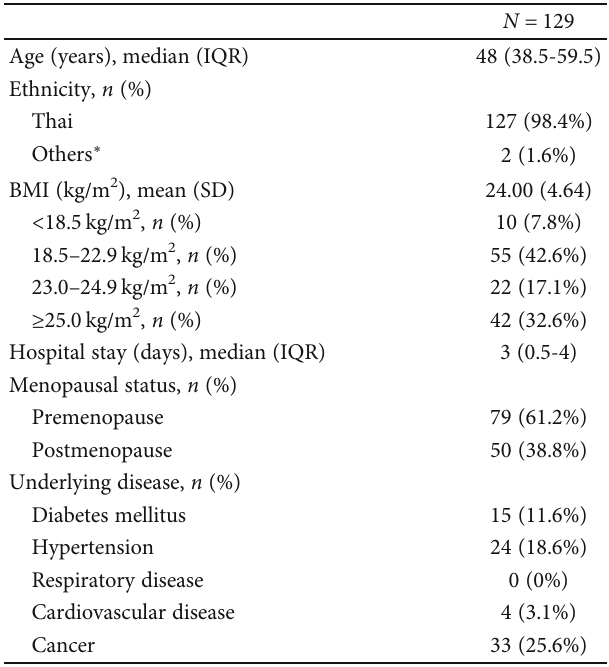
Table 1: Patient characteristics.